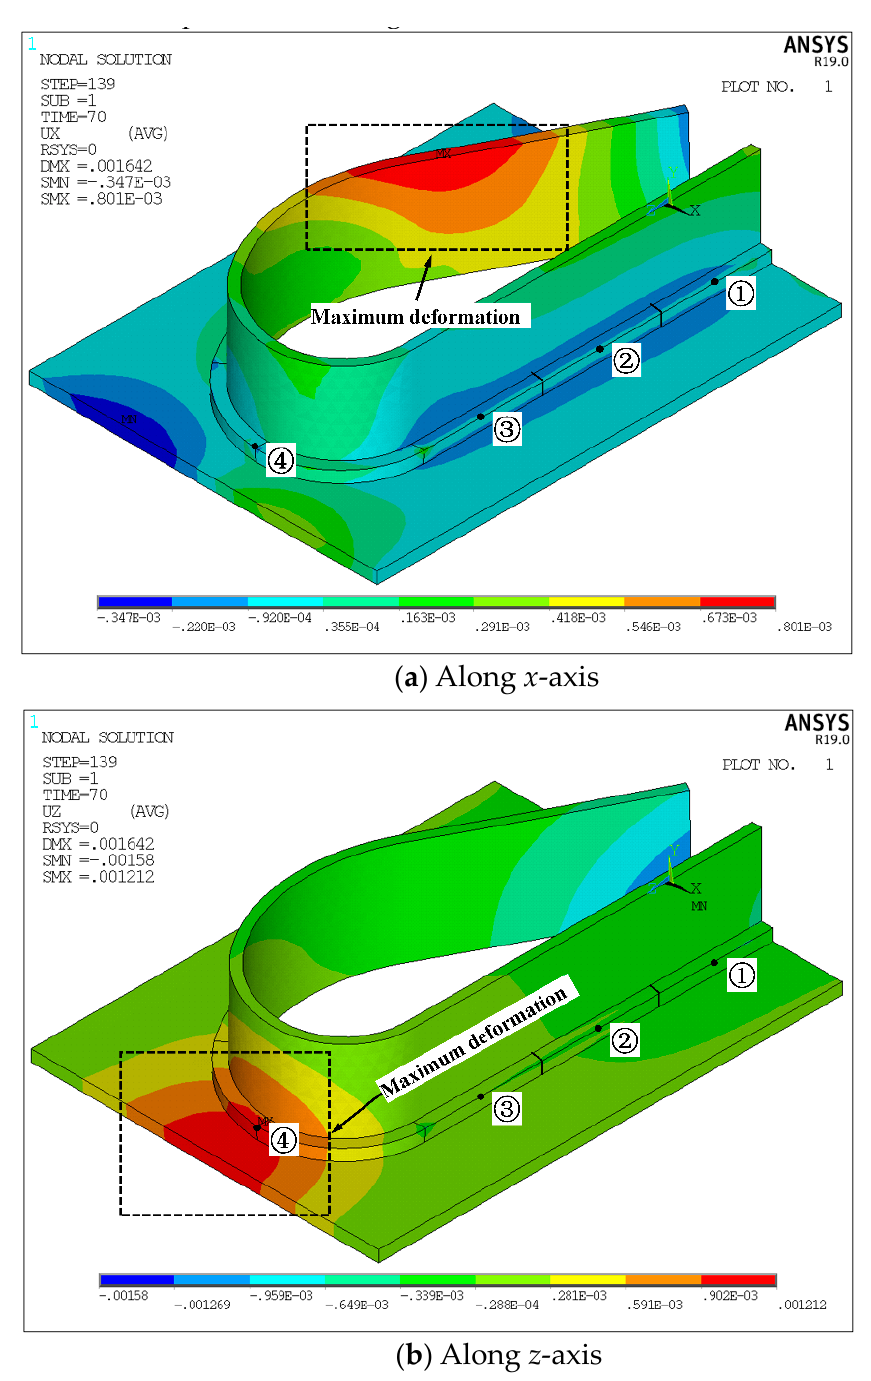
Figure 13. Welding deformation cloud map of welded structure 4 along the x -axis and z -axis under the optimal welding sequence.